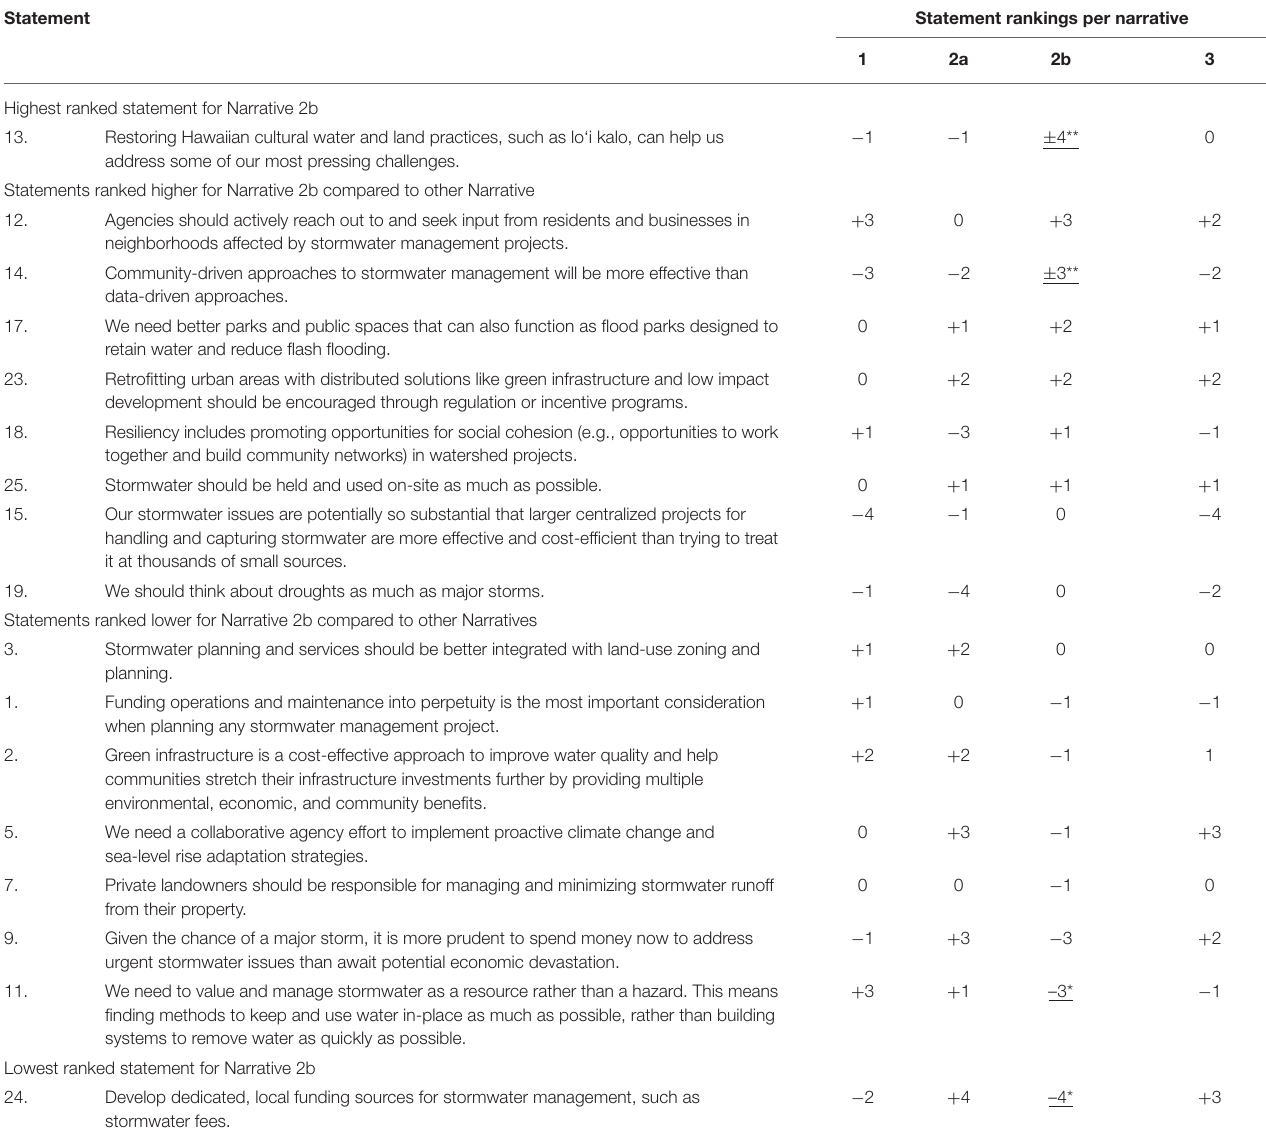
TABLE 6 | Summary of notable statements for narrative 2b (PC